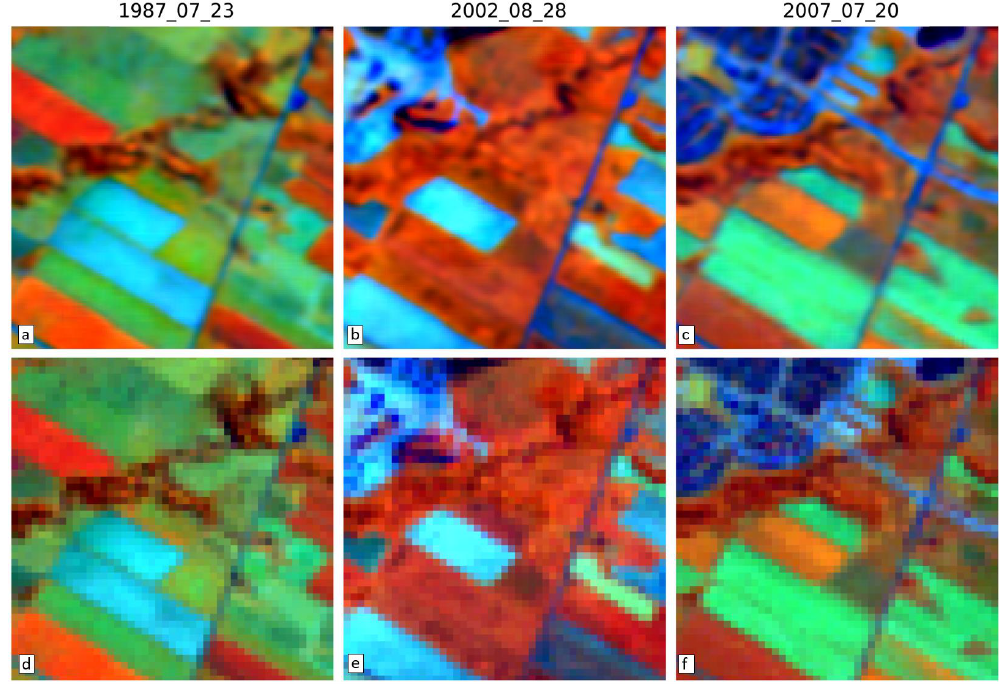
Figure 8. Example temporal extension result for a cropland area. ( a,b,c ) is the spatially enhanced result and ( d,e,f ) is the original Landsat.